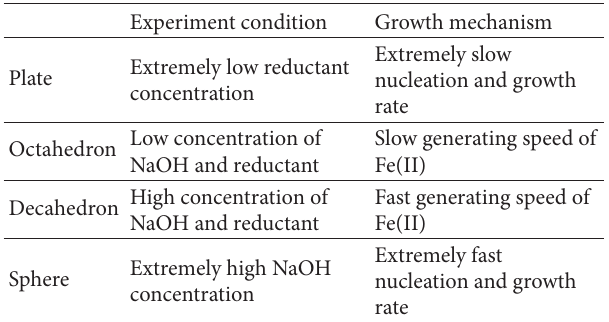
Table 1: The experiment condition and growth mechanism of typical Fe 3 O 4